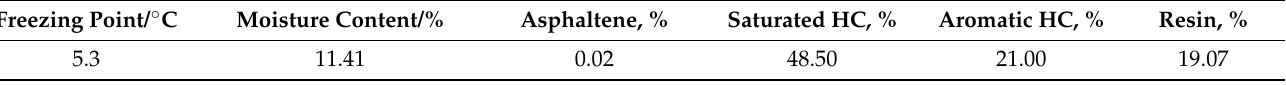
Table 1. The physical parameters of Heavy